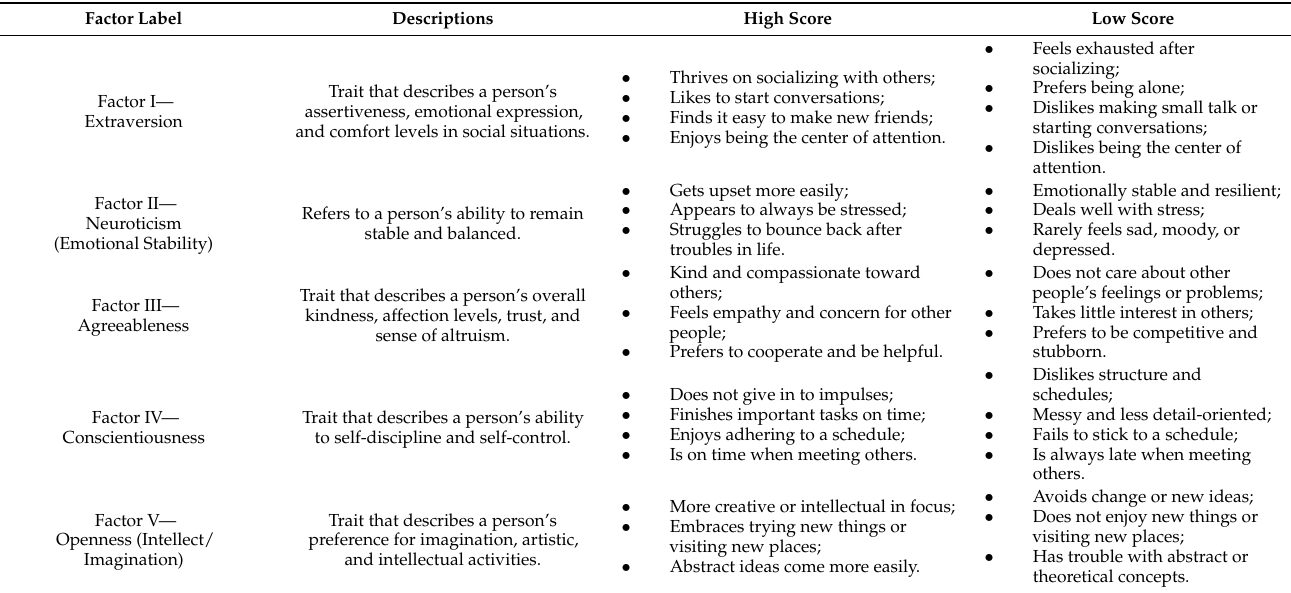
Table 1. Big-five factor markers and their descriptions in base on